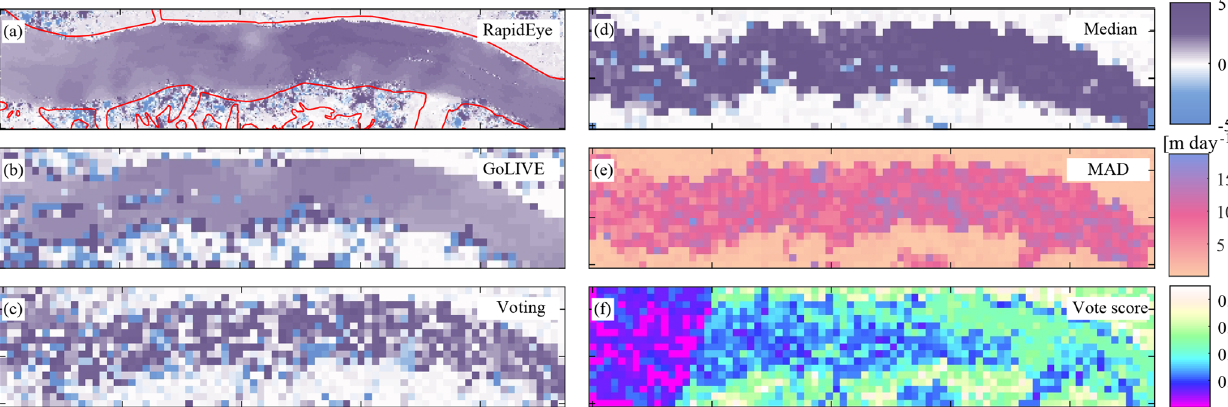
Figure 9. Monthly displacement in the x direction over the Klutlan Glacier (for location see Fig. 7) using several data sources and velocity assessment schemes. Panel (a) shows velocities derived from two RapidEye images. Glacier borders are outlined in red. Panel (b) shows displacement estimates from a GoLIVE dataset (input) and the resulting voted estimate (c) of a combination of 36 GoLIVE datasets (out- put). The corresponding voting score of these estimates is shown in (f) . Panels (d) and (e) show the median and the median of absolute deviation (MAD), respectively, over the full dataset. These last two results would typically be used for data exploration.